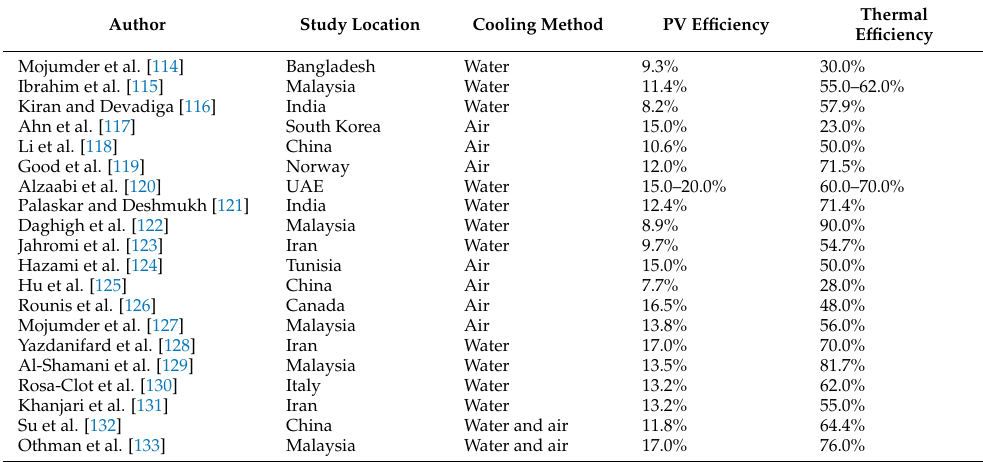
Table 3. Summary of literature review of PV/T system